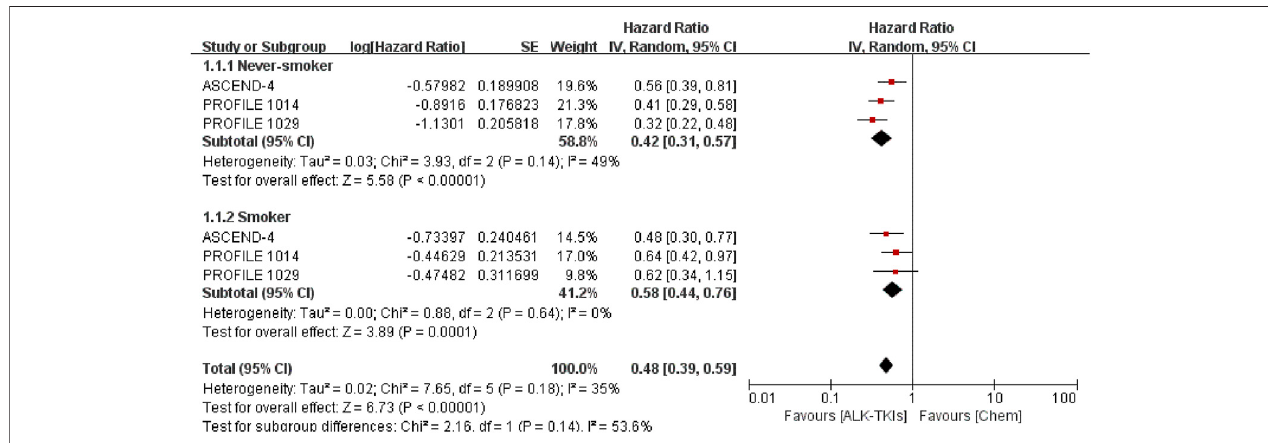
FIGURE 2 | Comparison between smoking status subgroups in chemotherapy-controlled studies. ALK-TKIs, anaplastic lymphoma kinase tyrosine kinase inhibitors; Chem,